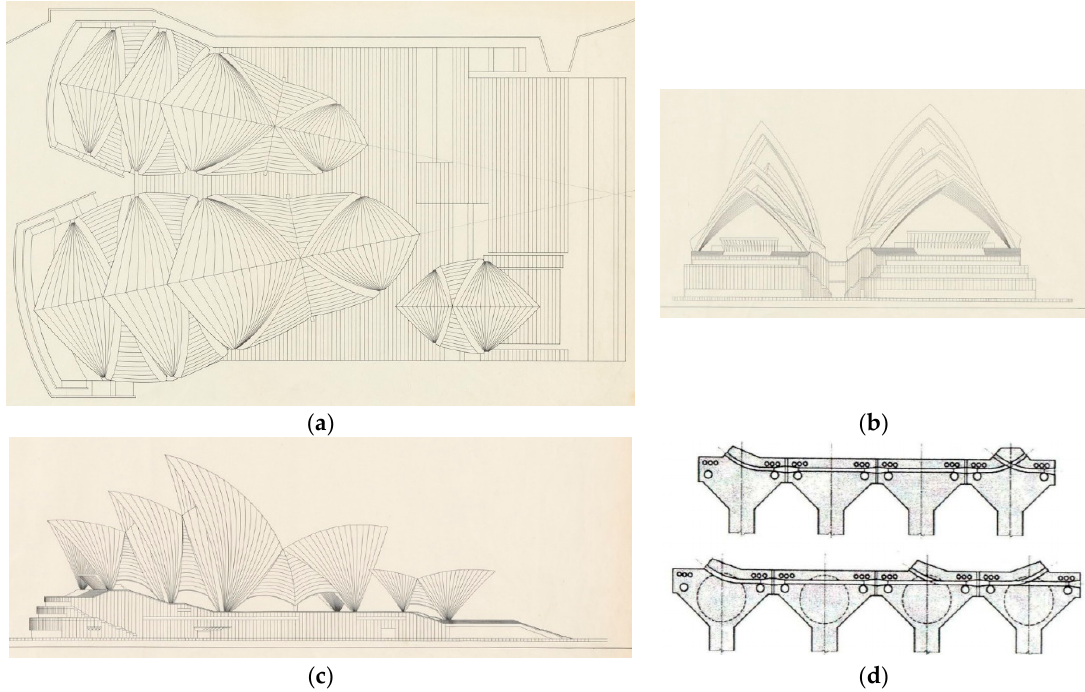
Figure 1. ( a ) Plan view, ( b ) north elevation, ( c ) west elevation (Utzon, 1962) Scale 1:32, ( d ) concrete rib cross-section ([8,9]).